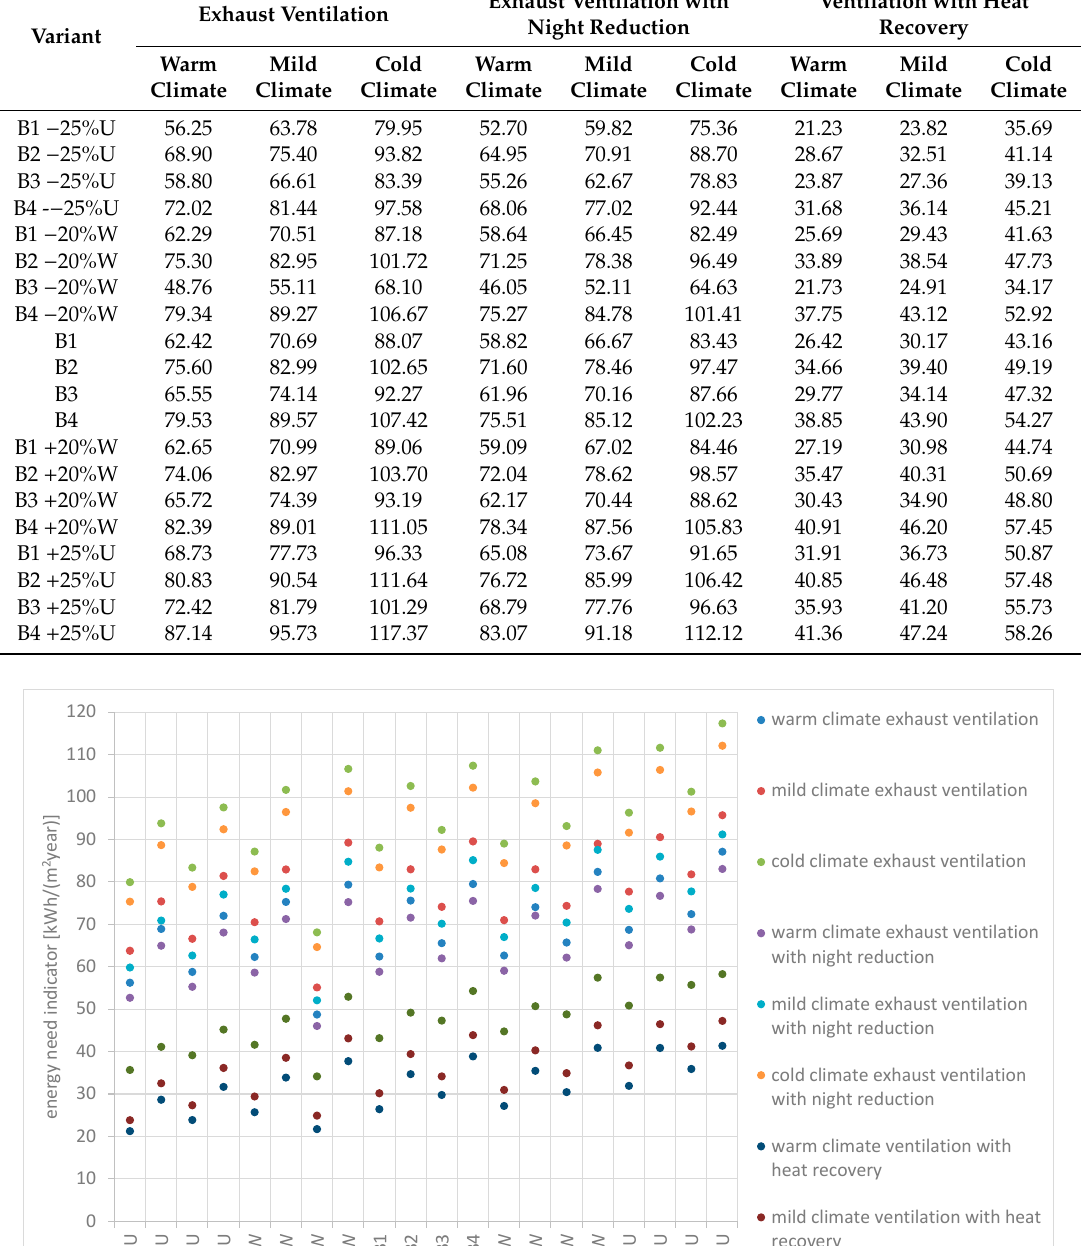
Table 5. Energy needed for heating indicator.